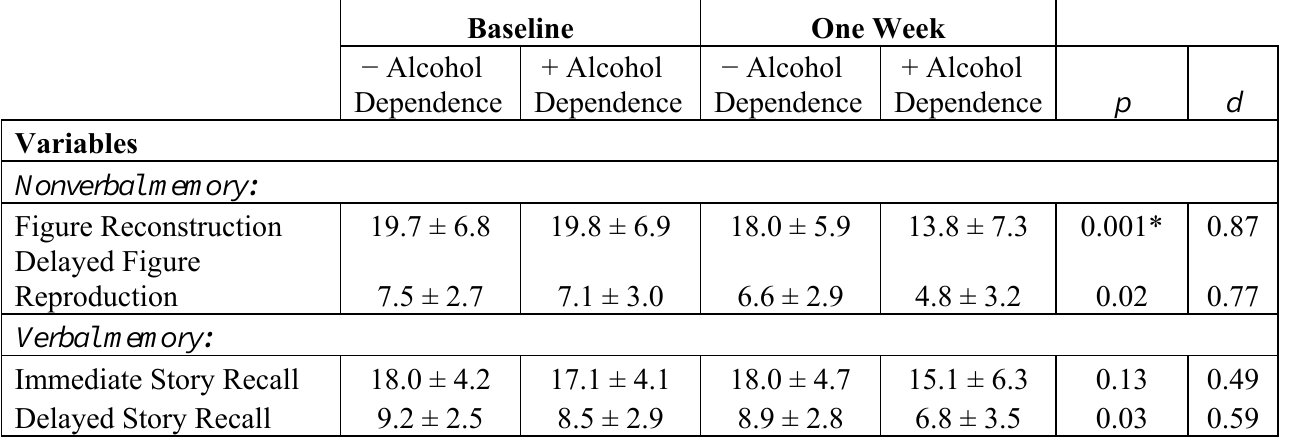
Table 3. Neurocognitive and depression scores before and one week after